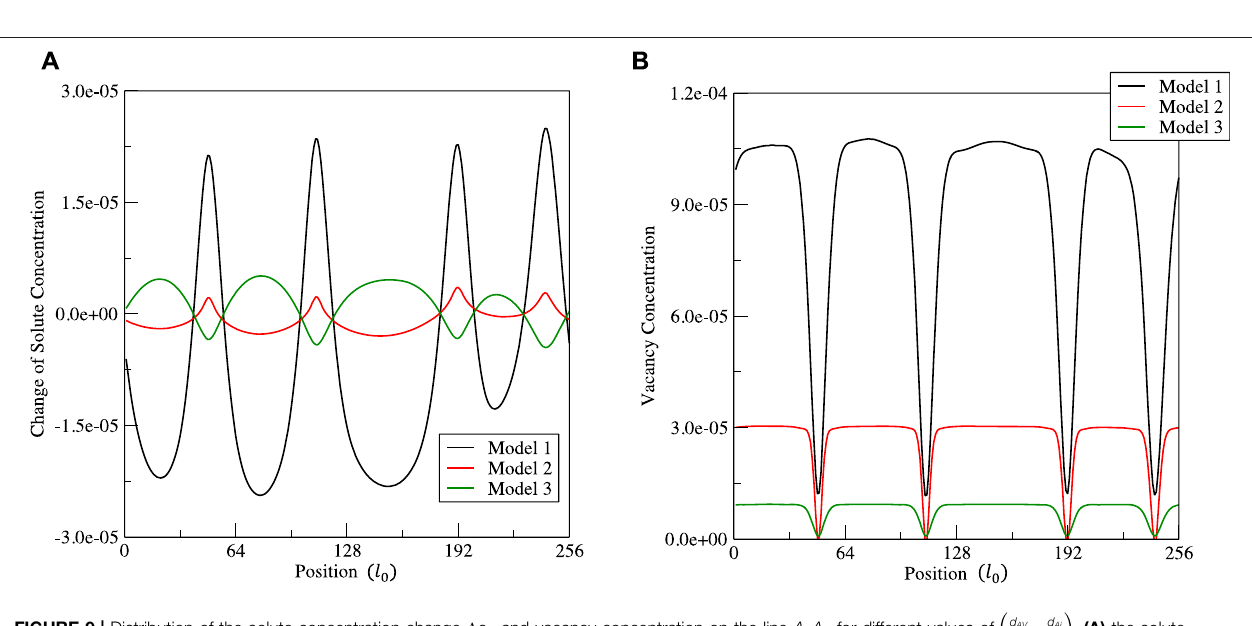
FIGURE 9 | Distribution of the solute concentration change Δ c A and vacancy concentration on the line A 1 A 2 for different values of (cid:22) d AV concentration change and (B) the vacancy concentration.